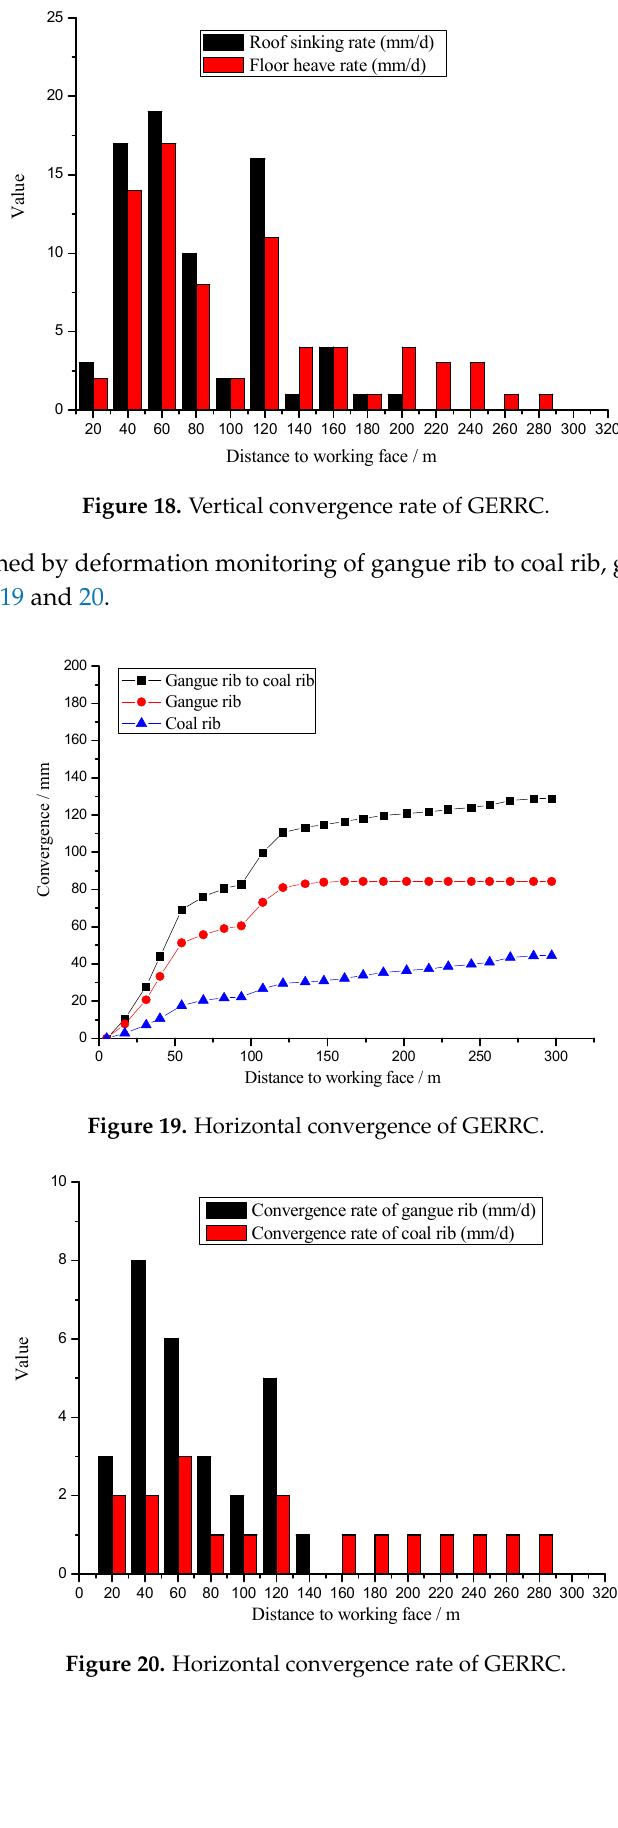
Figure 18. Vertical convergence rate of GERRC.